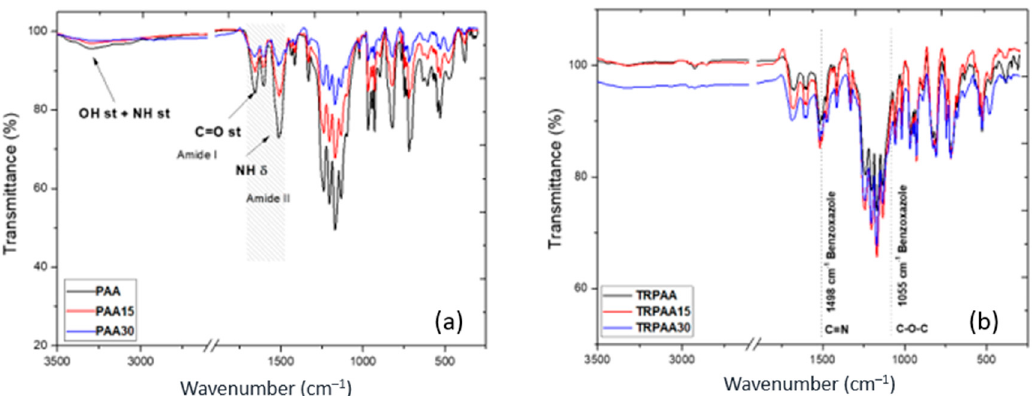
Figure 5. ATR-FTIR spectra ( a) of neat membranes; MMM (15 and 30% of PPN) PAA and ( b ) HPA-based and their corresponding TR-PBO-MMMs.